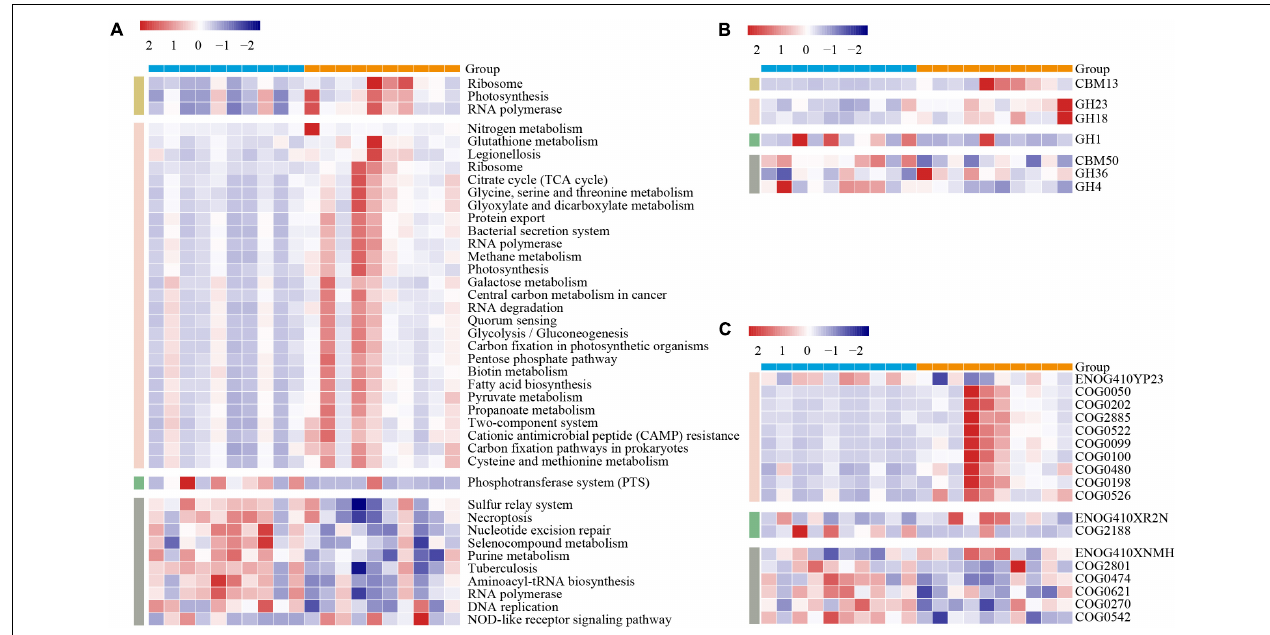
FIGURE 3 | Variations of the gut microbiome functions between the lean- and fat-line broilers. The functional categories of KEGG pathways (A) , carbohydrate-active enZYmes families (B) , and eggNOG ortholog groups (C) were compared between the lean and fat lines through non-parametric Mann–Whitney U test, in which p -values less than 0.05 were shown in the figure. These functional categories that participated in the comparison existed in all samples of at least one line with relative abundances that were over 0.1%. The color scale represents the row Z score. The blue and orange patterns in the upper bound of each heatmap are the individuals of lean line and fat line, respectively. The yellow, pink, green, and gray patterns in the left part of each heatmap represent the duodenum, jejunum, ileum, and ceca,